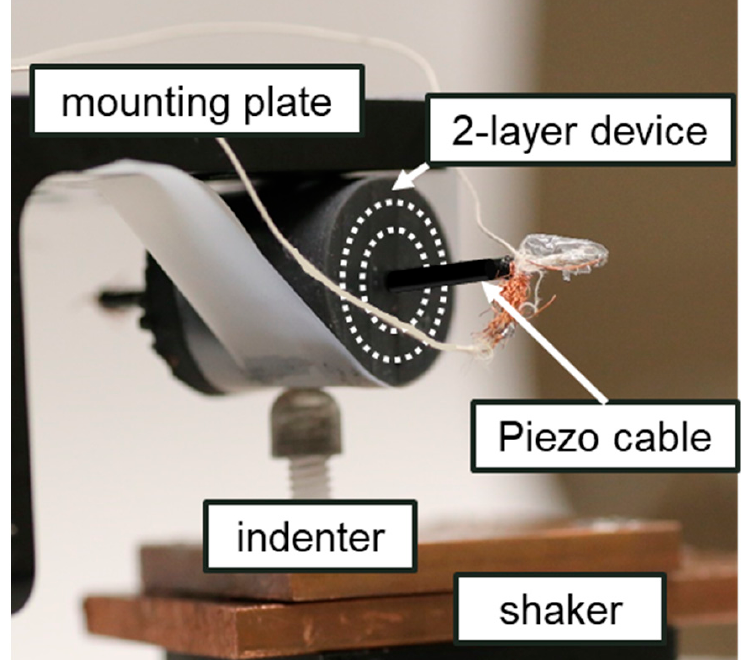
Figure 5. Experimental setup for vibration testing. Accelerometer not pictured. The artificial PC is attached to the static top plate and subject to indentation from below.